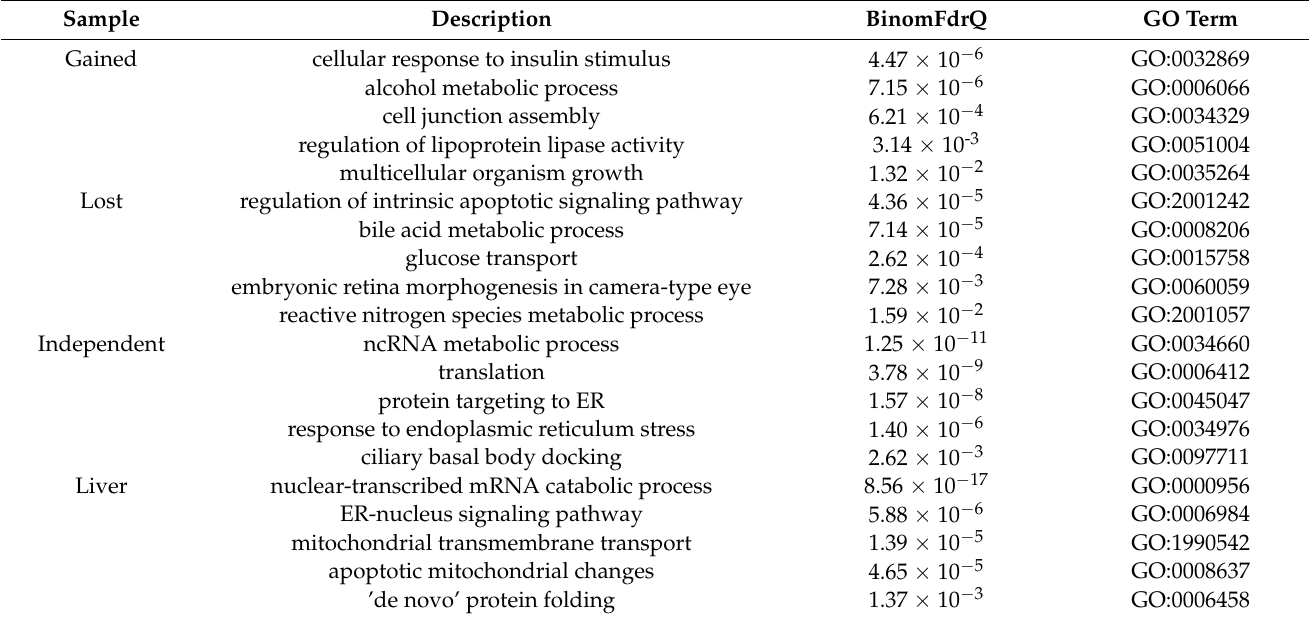
Table 1. GREAT analysis of ESR1 ChIP-Seq peaks, top five terms are